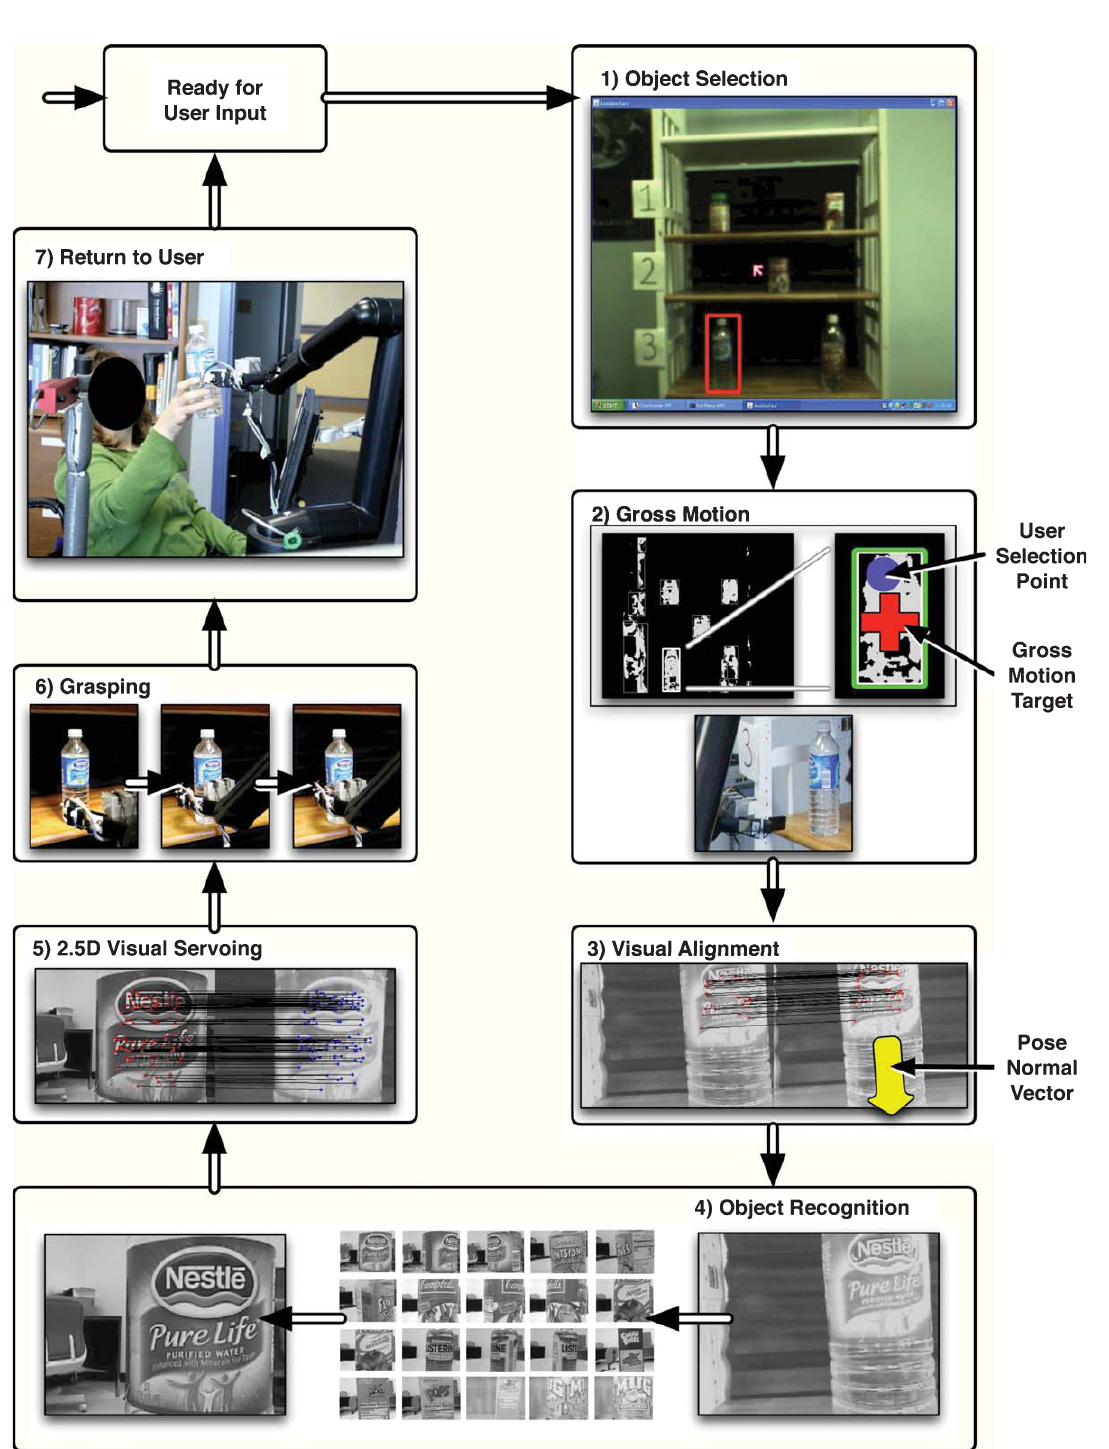
Fig. 2. The user provides input via touch screen or joystick. The input is used in the vision processing to position the robotic arm (best viewed in